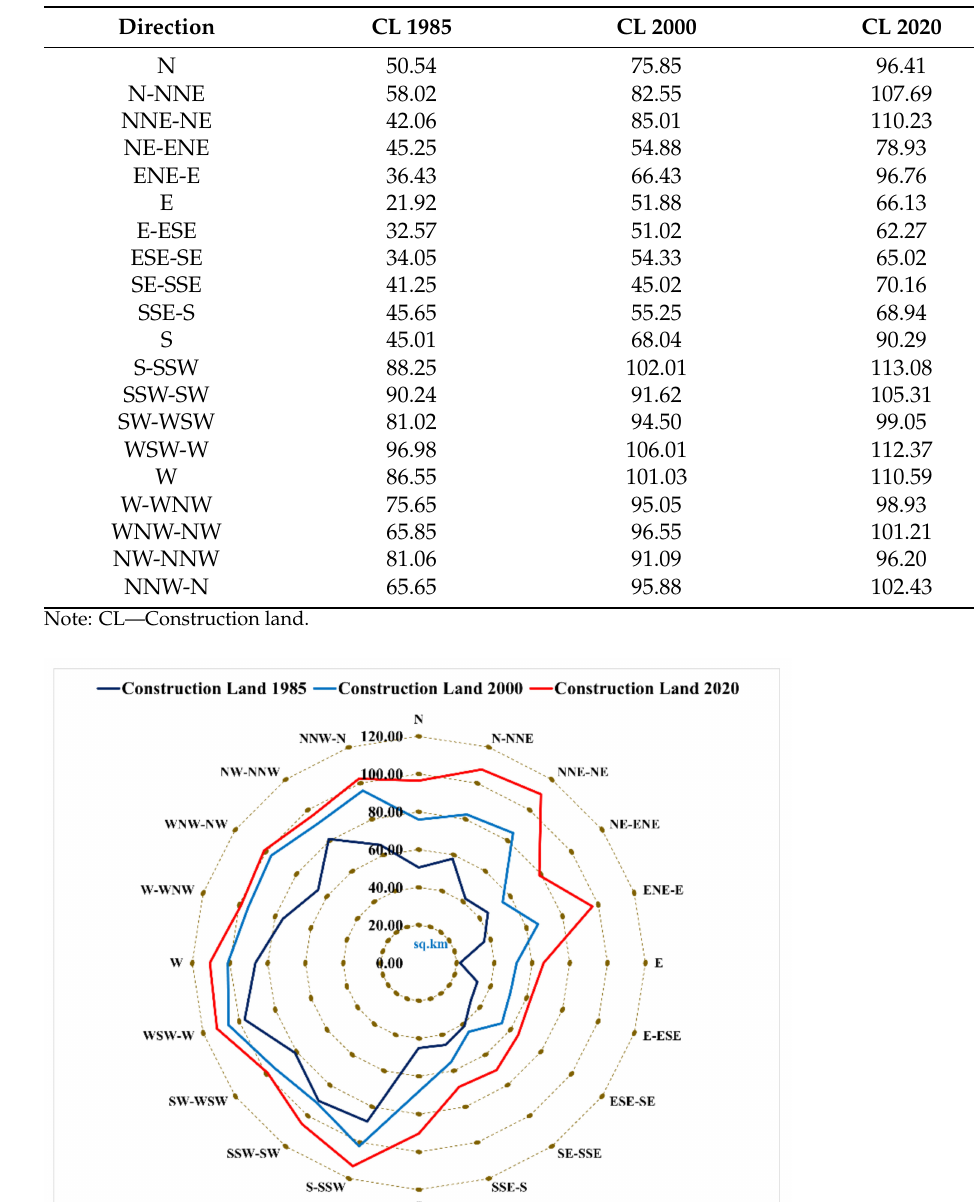
Table 5. Urban CL expansion (area in km 2 ) based on directional change.